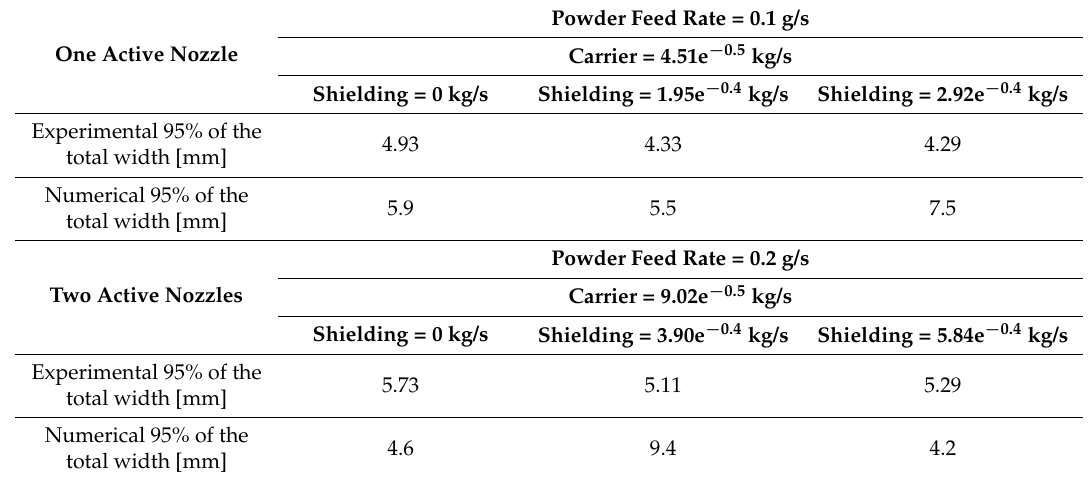
Table 3. Comparison between experimental and numerical